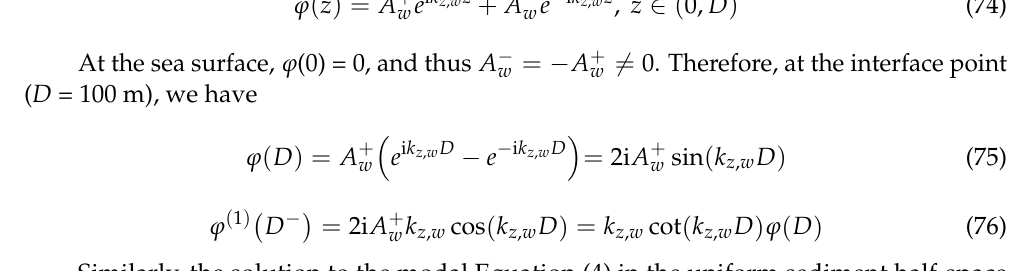
12 of 19 Figure 3. The real and imaginary parts of solutions in the plane-wave reflection case with PPW = 6.